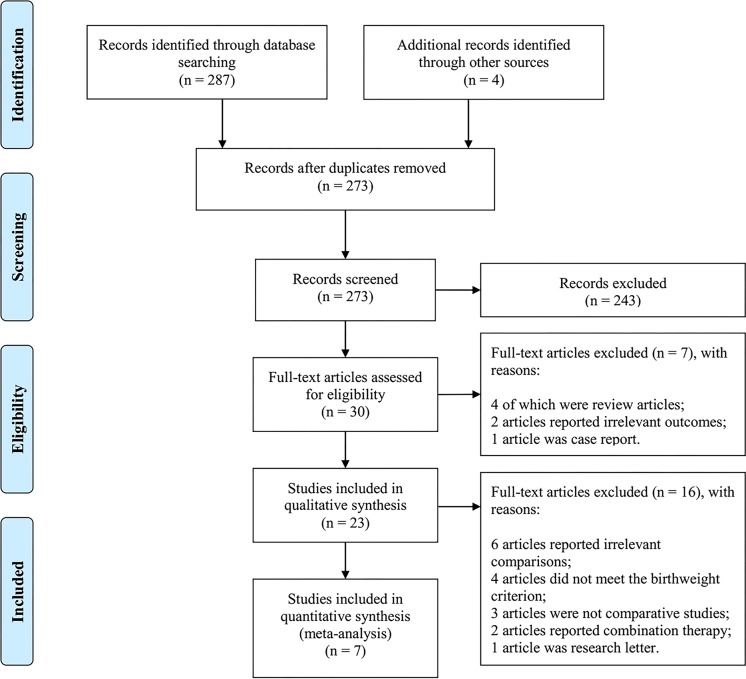
PRISMA flow diagram of study selection.